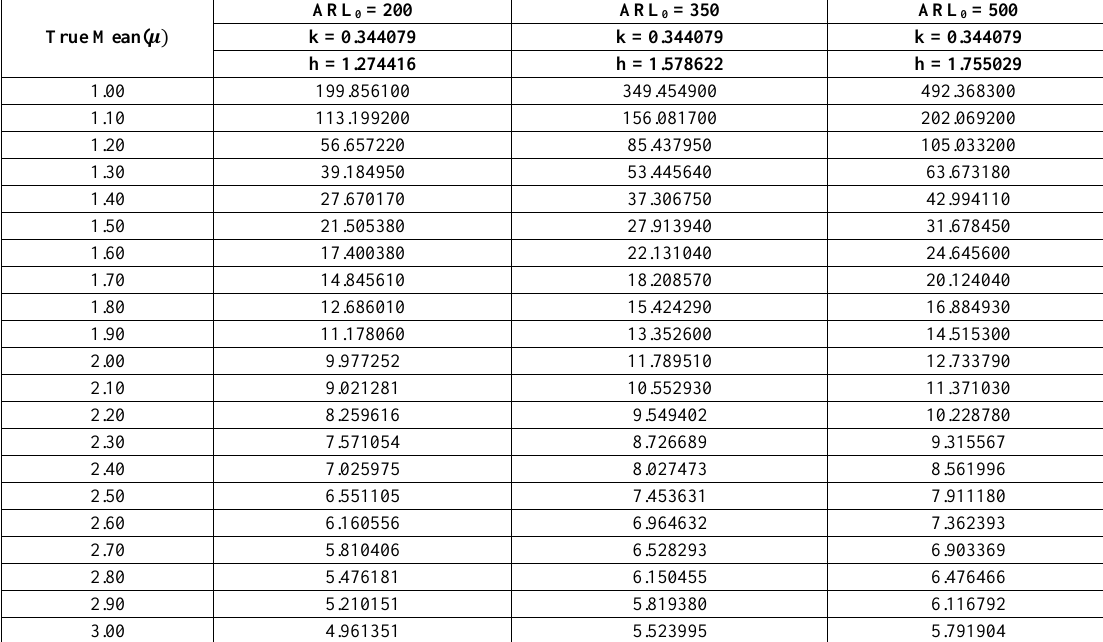
Table 2. Simulated ARLs for the combined Shewhart-CUSUM scheme for normalized exponentially